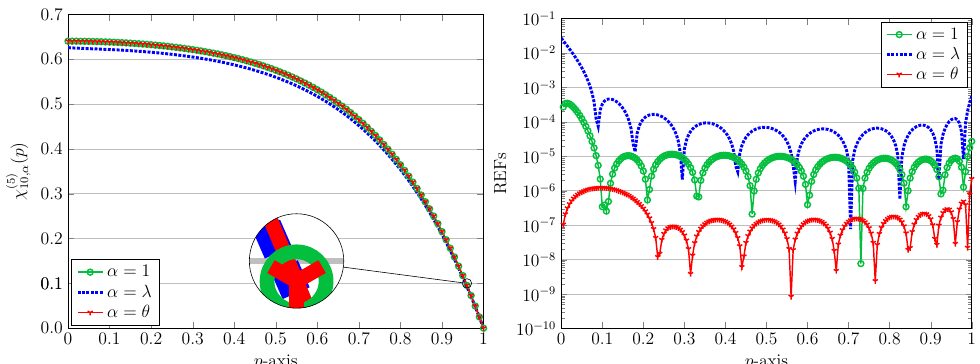
Figure 5. Graphics of numerical solutions obtained via the QLM-GSAPSK technique ( left ) and related 2 = 1, and with fractional-orders θ = 1.9, λ = REFs ( right ) with R = 10, α = 1, λ , θ , δ = 0.5, H